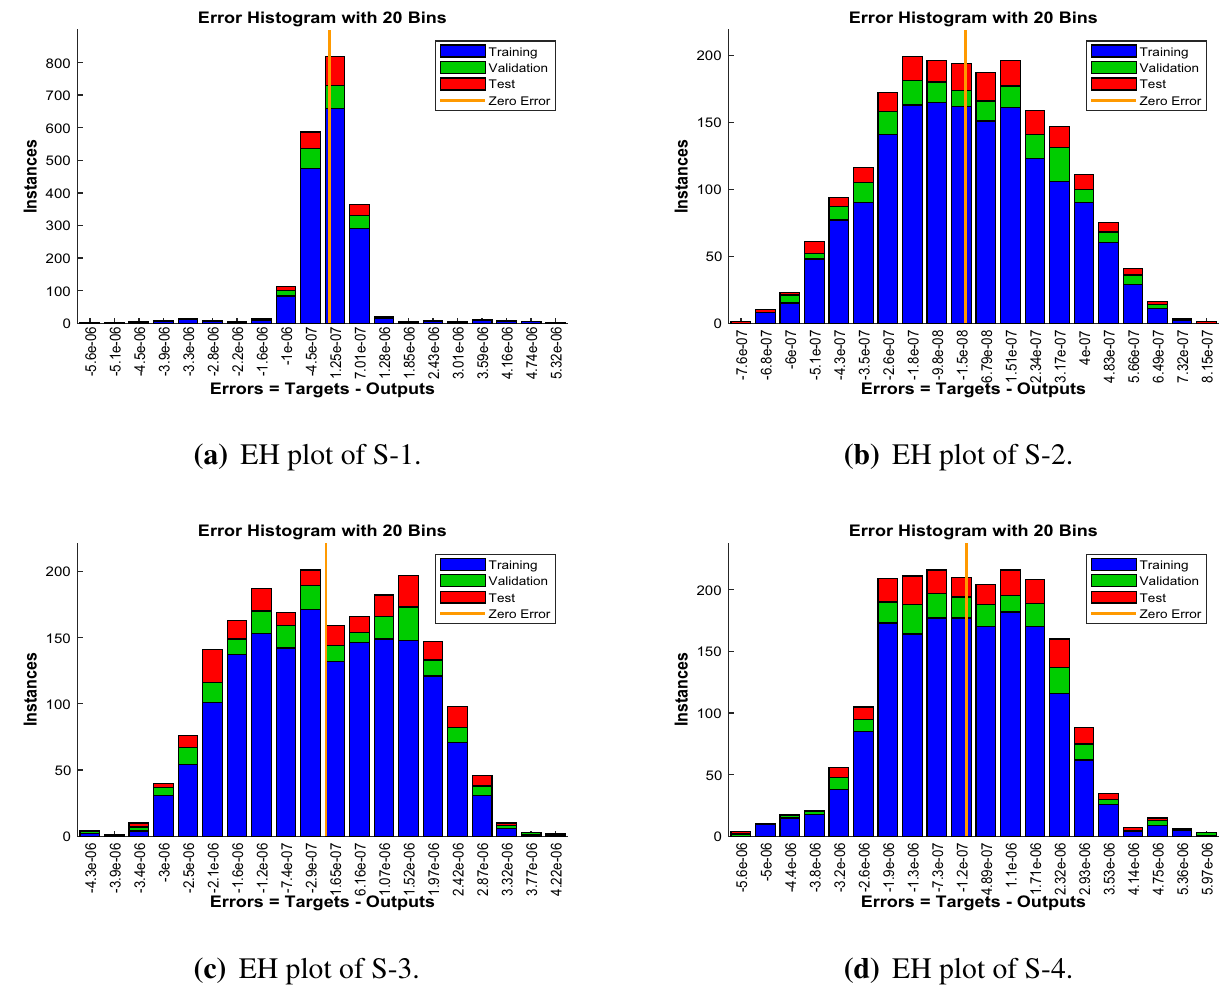
Figure 8. Error-histogram (EH) views of LMA-TNN for case 2 in constant